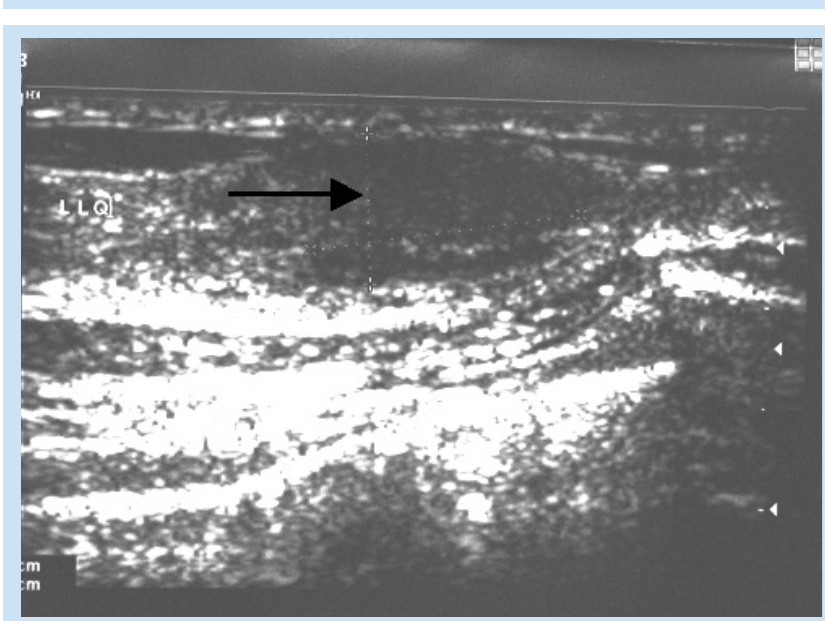
Fig. 3. Ultrasound of the left breast demonstrates an ill-defined irregular hyperechoic lesion suggesting malignancy